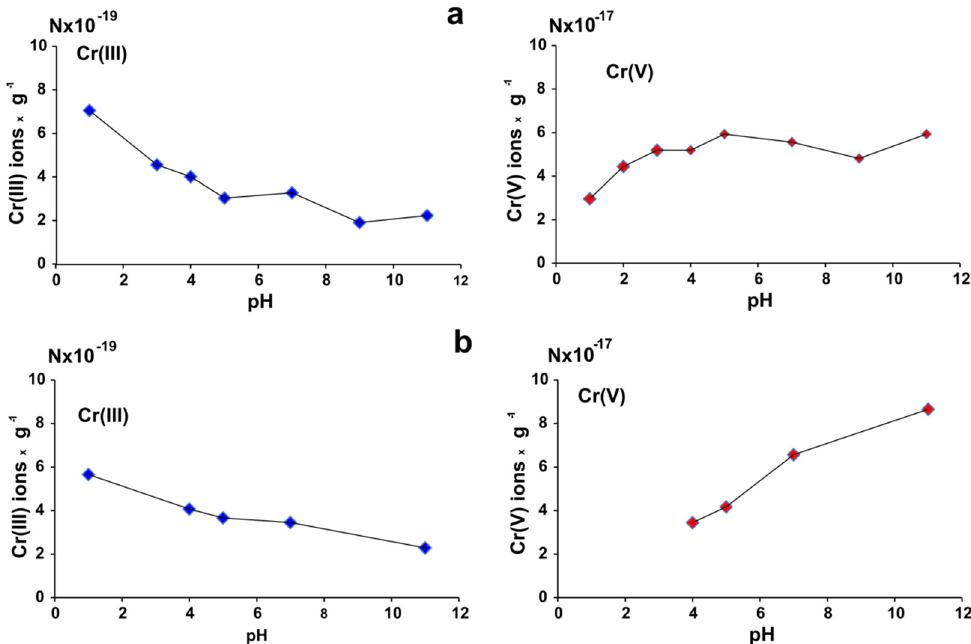
Figure 8. Number of Cr(III) and Cr(V) ions adsorbed on native potato starch ( a ) and on monostarch phosphate ( b ) with 0.33 wt% P as a function of pH value of the solution. Experimental conditions: for native starch initial Cr(VI) concentration = 5 g/L, volume = 22.5 mL, starch amount = 5 g, contact time = 24 h.; for phosphorylated starch: initial Cr(VI) concentration = 1 g/L, volume = 22.5 mL, starch amount = 1 g, contact time = 24 h, room temperature.